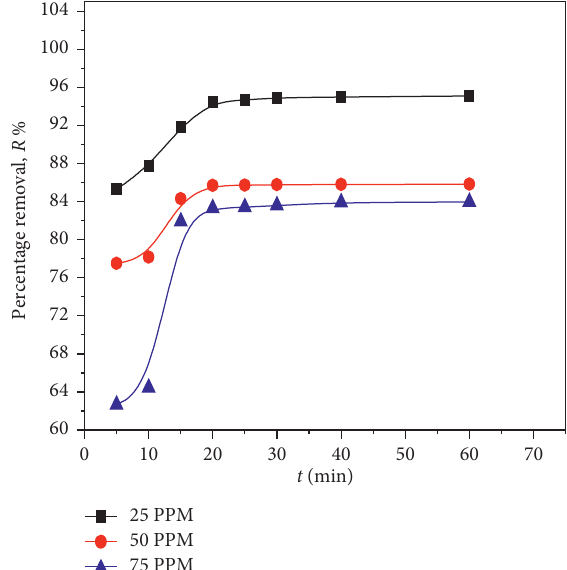
Figure 10: Effect of contact time on the adsorption of BG dye onto